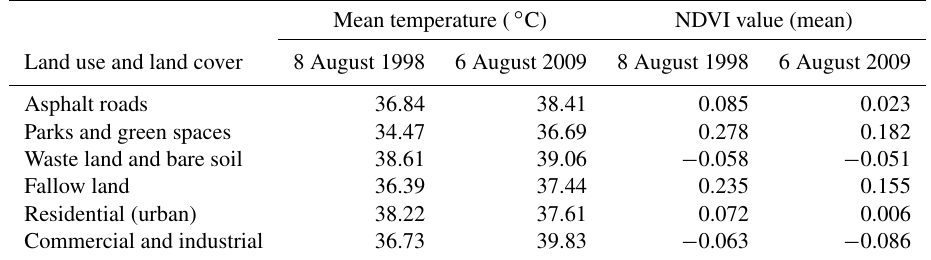
Table 9. Relationship between surface temperatures with NDVI of the different land use